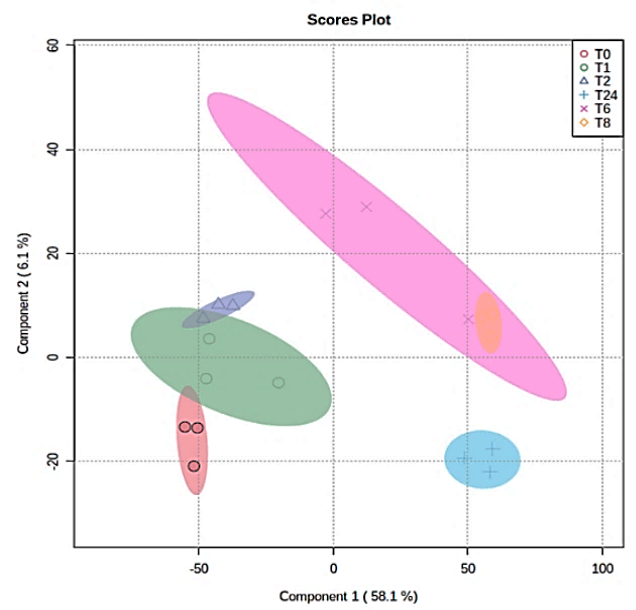
Figure 4. Sample clustering and group separation based on a group of 1760 features. PLS-DA for the effect of the E. coli secretome treatment on MDA-MB-231 cells at different time points (0, 1, 2, 6, 8, and 24). O T0, O T1, ∆ T2, X T6, ◊ T8, + T24 h.